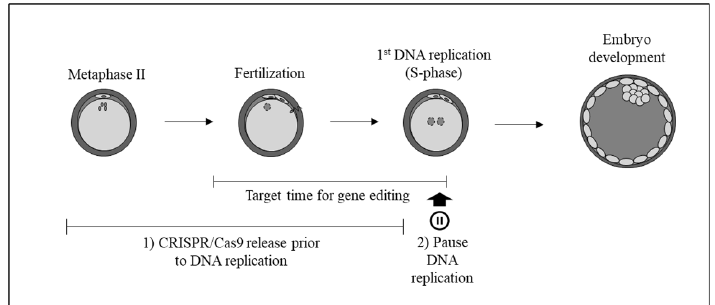
Figure 1. Possible time-related strategies to decrease mosaicism: 1 ) Injection of CRISPR/Cas9 to act before DNA replication. 2 ) Use of inhibitors to temporarily pause DNA replication thus increasing the time for the CRISPR/Cas9 system to work.